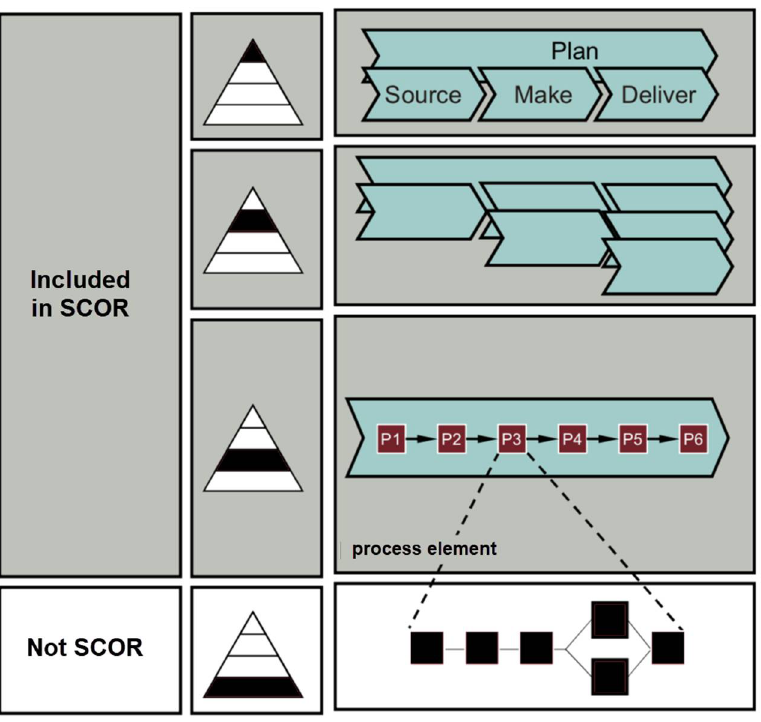
Figure 1. SCOR process level. Adapted from Ref. [31].